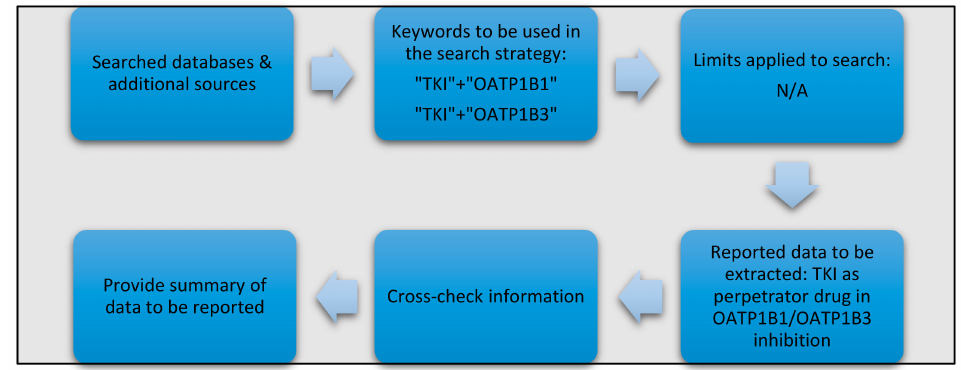
Figure 1. Applied methods for the acquisition of relevant data on TKI-related interactions with OATP1B1 and